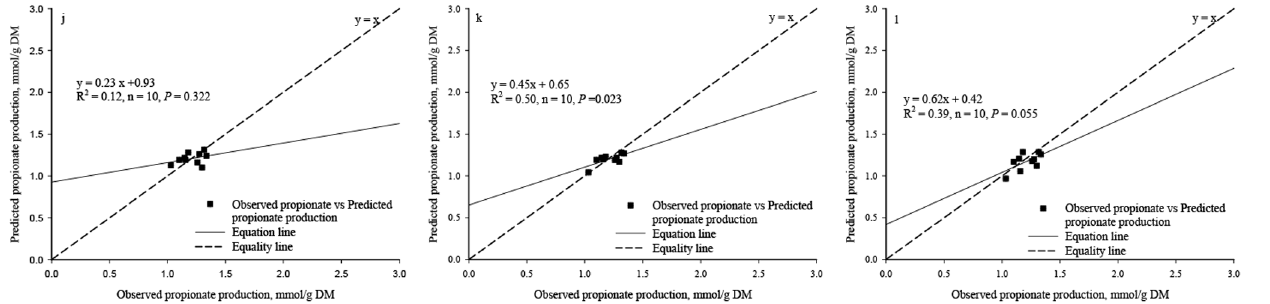
Fig. 6. Relationship between the observed vs. the predicted propionate production. ( j . Predicted values were from Equation IV; k . Predicted values were from BP3 model where propionate production using as individual output; l . Predicted values were from BP3 model where propionate production was output